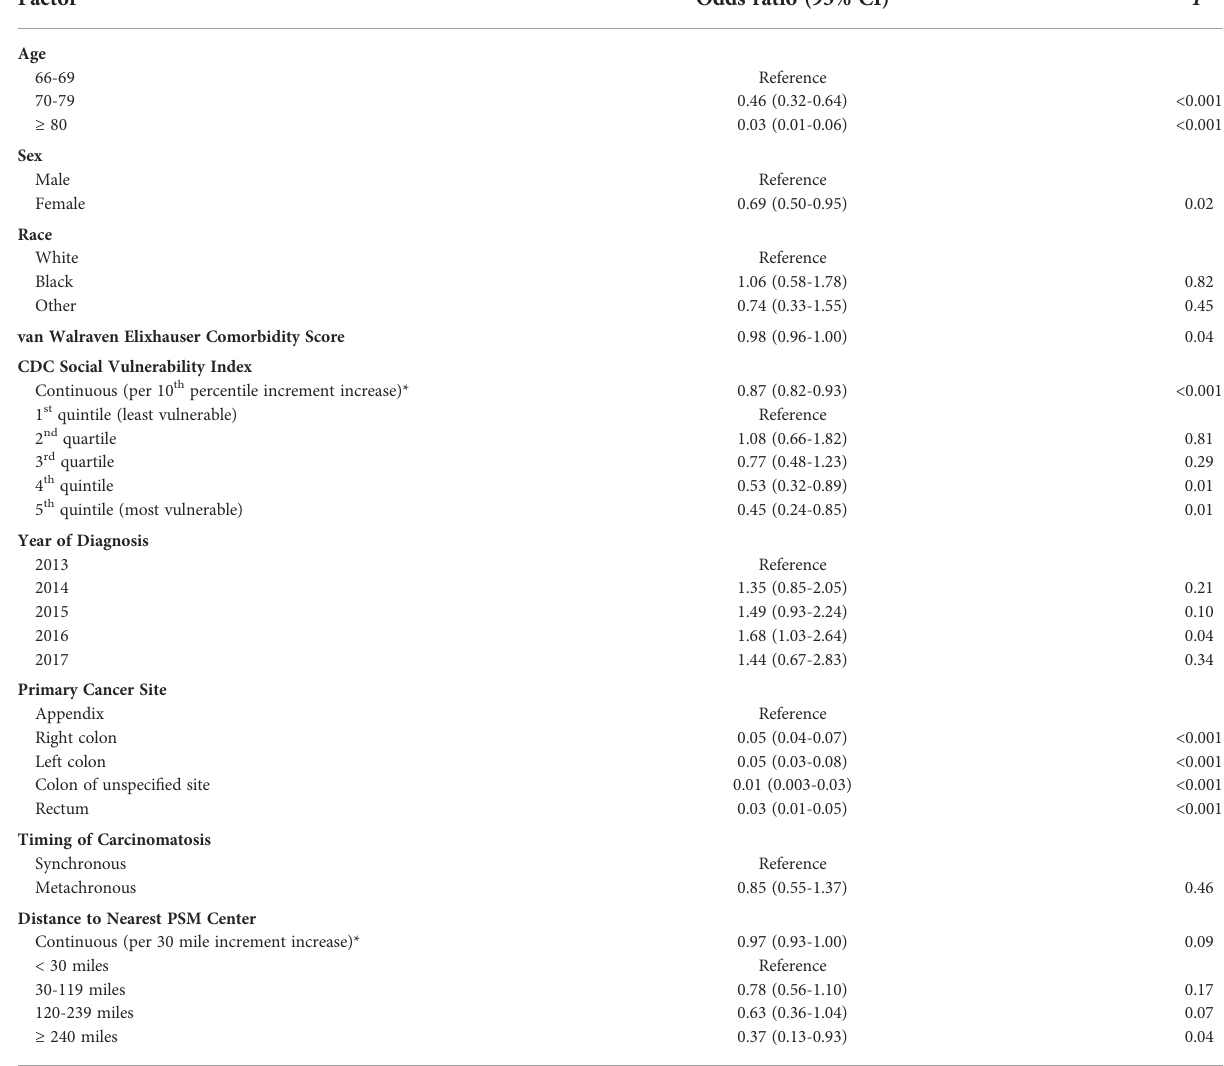
TABLE 2 Mixed-effects multivariable analysis of factors associated with